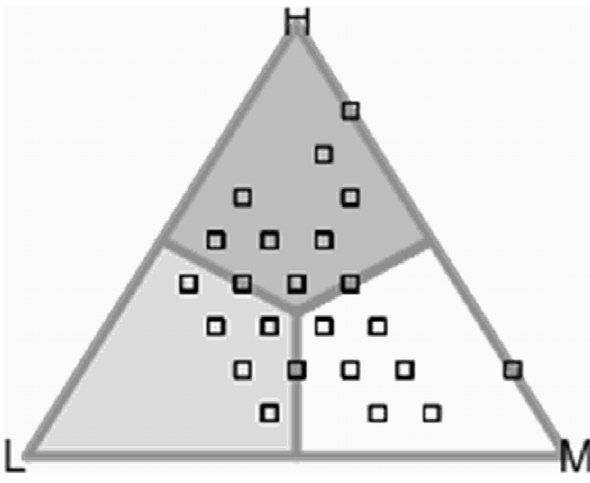
Figure 3. 2-simplex representation of the state space used in both intratype and intertype bargaining games. The shaded regions correspond to the state subspaces in which an agent always decides one of the three possible demands {L,M,H}. For example, the light grey area at the bottom-left of the triangle represents a set of states in which the majority of the items in the memory are L, and therfore the agent will demand H. The opposite happens in the dark grey area at the top. Finally the M demand dominates the agents’ memories in the white area, so the response of the agent in that area is also M. Note that with the mode-decision rule, the centre of the triangle, which is equidistant from the three vertices, corresponds to the indifferent state in which any of the three demands is equally possible.